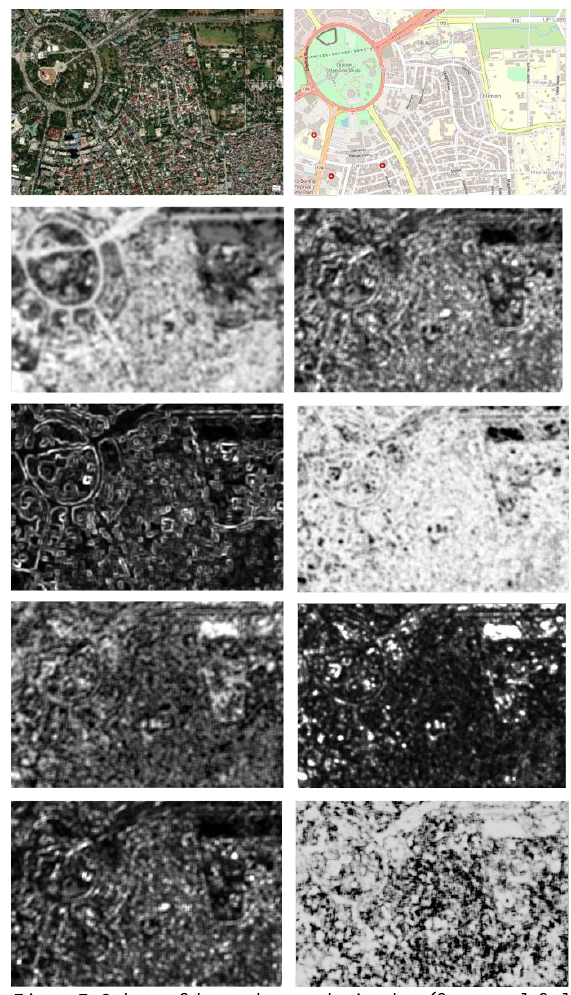
Figure 7. Subset of the study area depicted as (from top-left, left to right) Satellite image, OSM map, and GLCM textures from VgNIR-BI: Mean, Dissimilarity, Variance, Entropy, Homogeneity, Second Moment, Contrast, and Correlation.